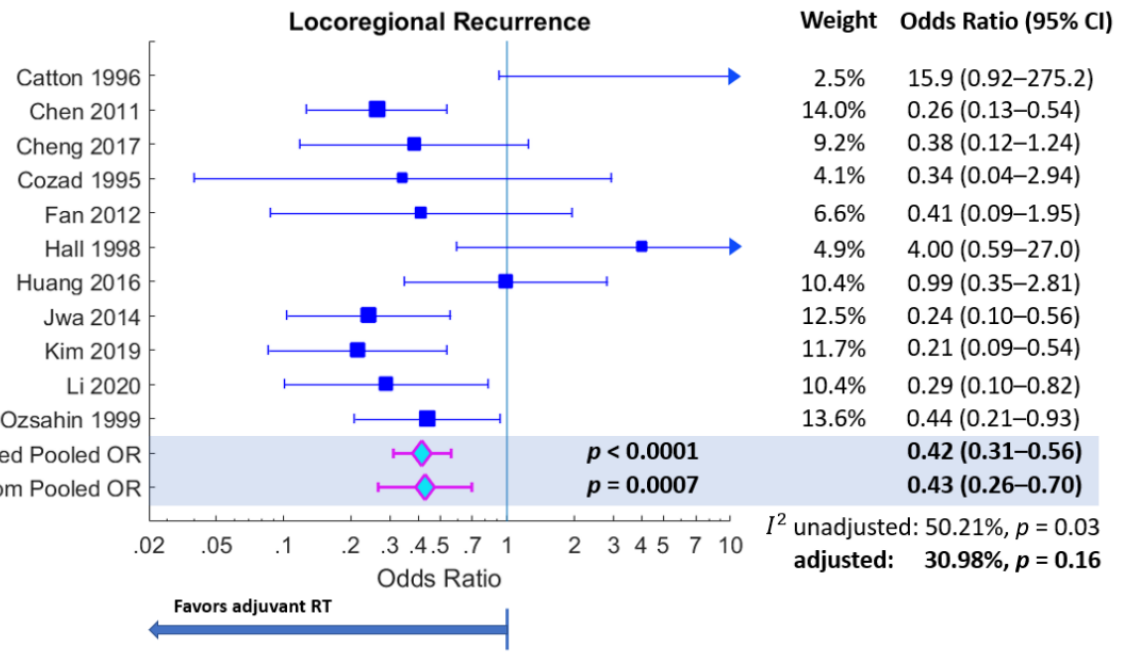
Figure 2. Forest plot for primary outcome of locoregional recurrence. Weights are from the random- effects model. The adjusted inconsistency measure ( I 2 ) pertains to recalculation of the measure after excluding the study by Catton et al. (1996).